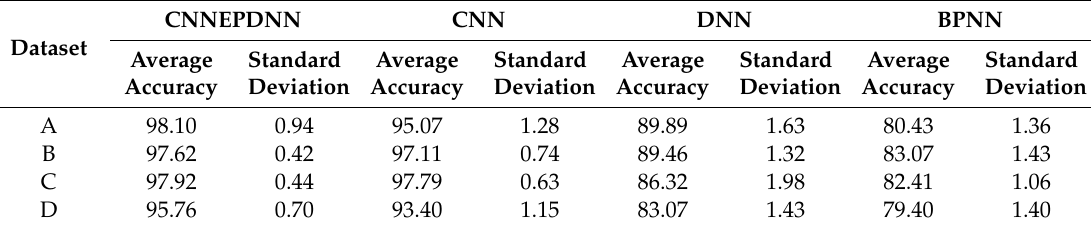
Figure 8. Testing accuracy results of the proposed method and CNN, DNN, BPNN in 10 trials: ( a ), ( b ), ( c ) and ( d ) are the test accuracy of four methods on dataset A, B, C and D, respectively. Table 4. Average testing accuracy and standard deviation of comparative